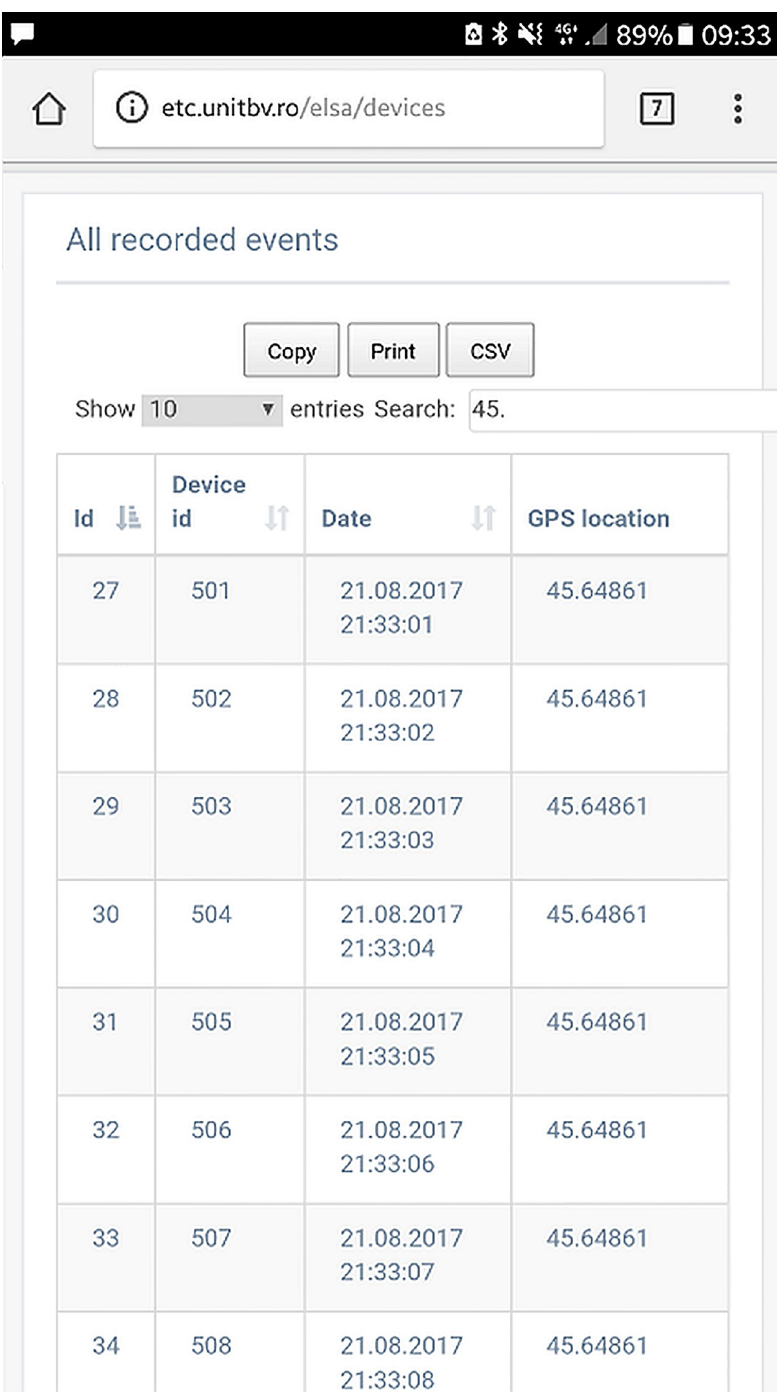
Fig 6. Screenshot from a mobile device showing the recorded events by the devices in a table format.